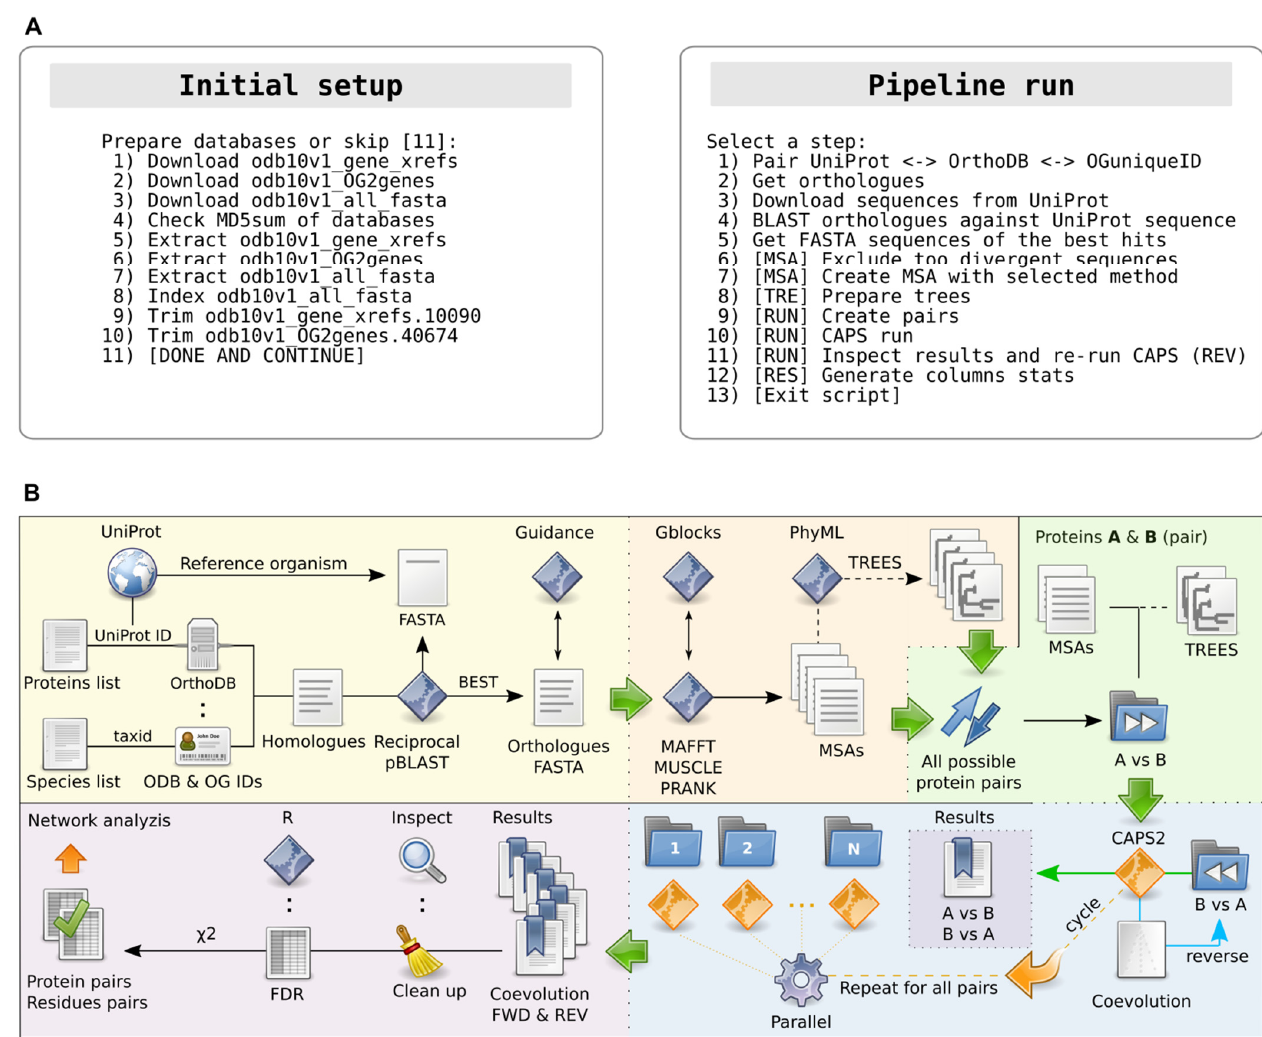
Figure 1. The pipeline of AutoCoEv. ( A ) Menu overview. Left : Steps 1–7 download, check, and extract databases; Steps 8–10 index and process the databases. Right : Steps 1–3 deal with homologous sequence retrieval; steps 4–5 carry out the identification of most appropriate orthologues; step 6 calls Guidance to exclude sequences that are too divergent; steps 7–9 create the MSA, phylogenetic trees, and protein pairwise combinations; steps 10–11 run parallelized CAPS for each unique protein pair combination “bidirectionally”; step 12 processes results and does statistical analyses. ( B ) Pipeline overview. Yellow : Reading the user-provided lists of proteins of interest and species to be searched, the script communicates between databases to extract genes (ODB), orthologous groups (OG), and protein identifiers (ID). Homologous sequences are then blasted against the UniProt sequences from the reference organism (e.g., mouse or human) in order to prepare a FASTA list of most appropriate orthologues. Before MSA, orthologues are assessed by Guidance and too-divergent ones are removed. Orange : Orthologues are aligned by selected method (MAFFT, MUSCLE, or PRANK) and scanned by Gblocks to report regions of low quality. PhyML calculates trees from the MSA generated in the previous step, optionally using an external tree as a guide. Green : Creates all unique protein pairs in folders, with each folder having two sub-folders for MSA and (if prepared by PhyML) trees. Blue : CAPS2 is run for each protein pair folder in a parallelized fashion via GNU/Parallel. If coevolution is detected, CAPS2 is run again, this time “reversing” the protein load order (e.g., A vs. B followed by B vs. A). Purple : The output in each pairs folder is inspected and processed, followed by FDR correction of p-values and chi-squared test. Finally, the results are prepared as a table ready for network analysis by